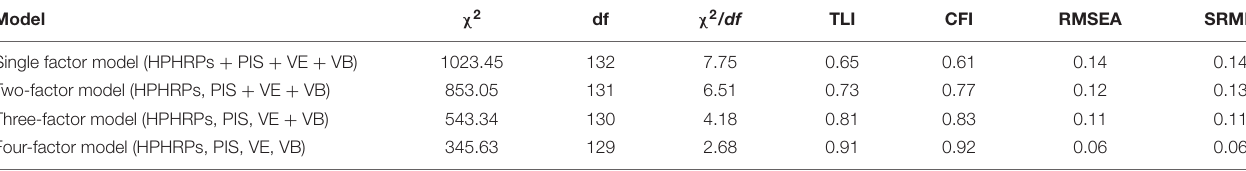
TABLE 2 | Results of confirmatory factor analysis.